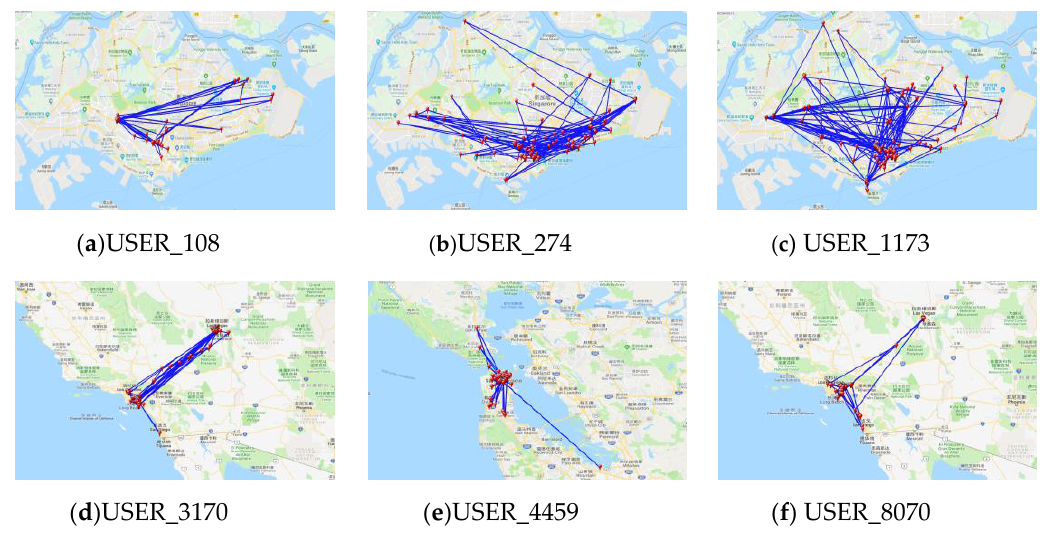
Figure 6. Di ff erent users’ check-in sequences on the map. ( a – c ) and ( d – f )are from the Foursquare and Figure 6. Different users’ check -in sequences on the map. ( a – c ) and ( d – f )are from the Foursquare and Gowalla datasets, respectively. Gowalla datasets, respectively.